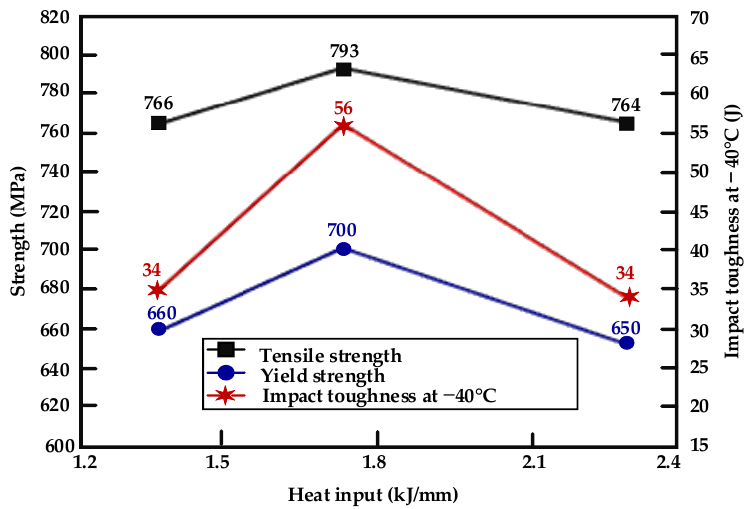
Figure 2. Results of mechanical properties of deposited metal.